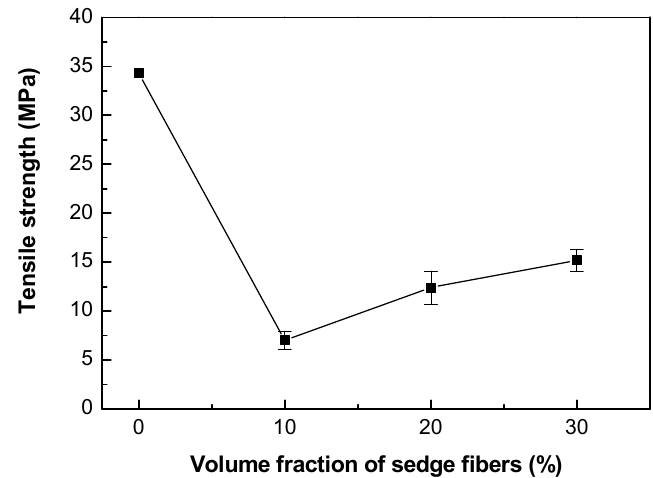
Figure 6. Tensile strength as a function of the fiber fraction for the neat epoxy resin and CM sedge fiber-reinforced composites.